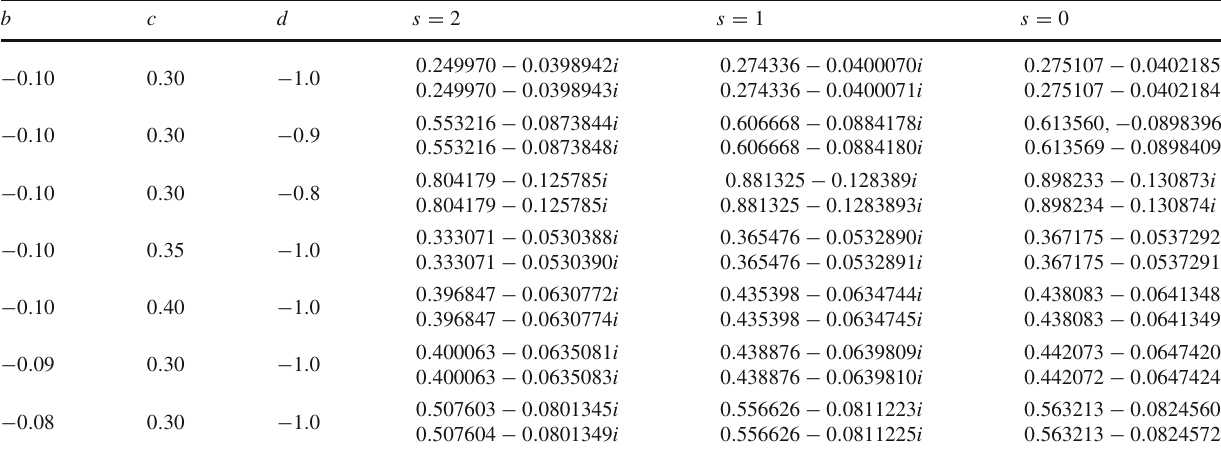
Table 2 The fundamental QNMs for (cid:16) = 3, calculated by using the AIM method (first row) and WKB formula (second row)